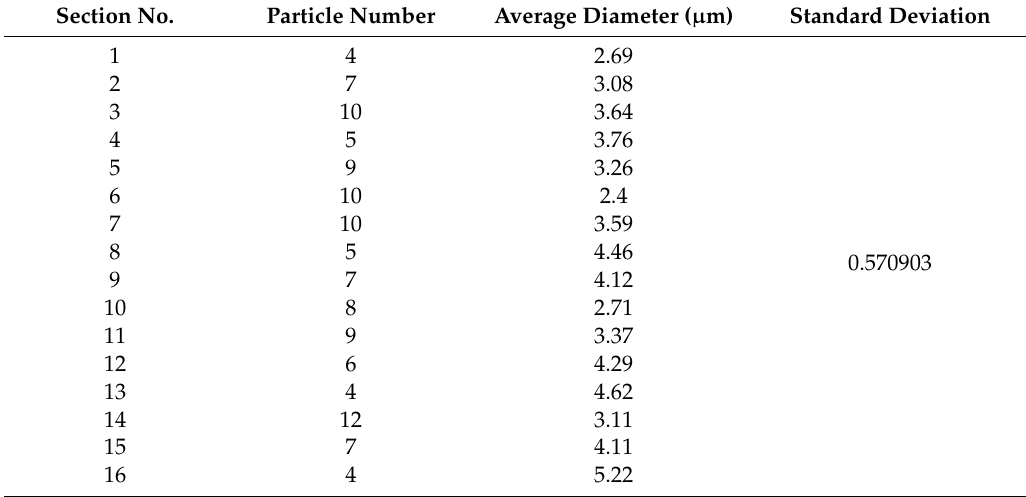
Table 5. Particle number and average diameter in each section